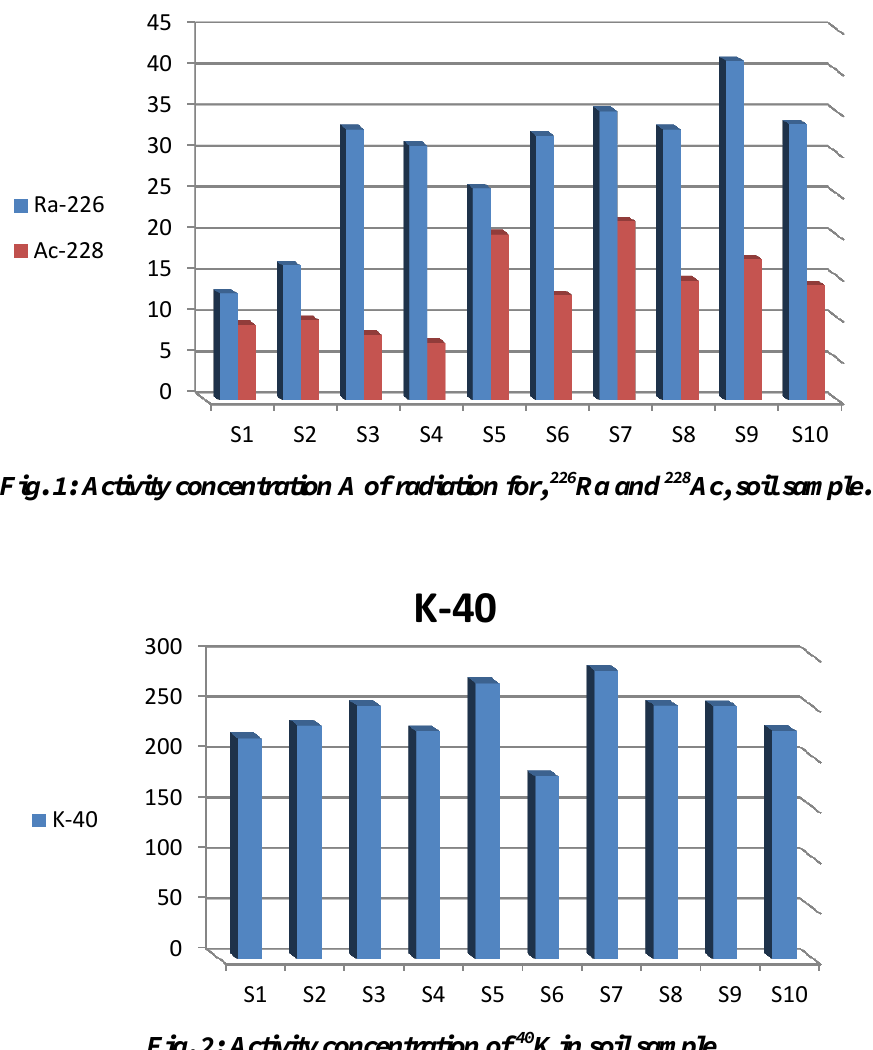
Fig. 2: Activity concentration of 40 K in soil sample .